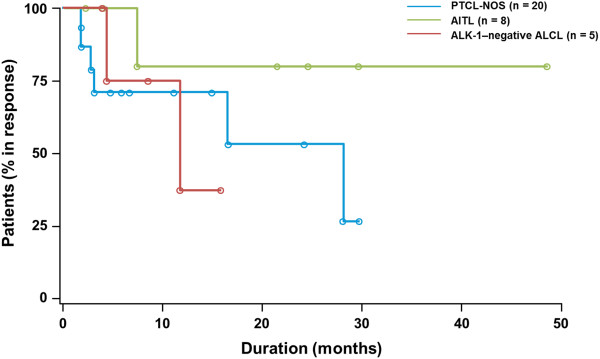
Durations of response for the 3 most common subtypes of PTCL in patients who achieved a response (CR or PR). ◦ Indicates a censored patient.